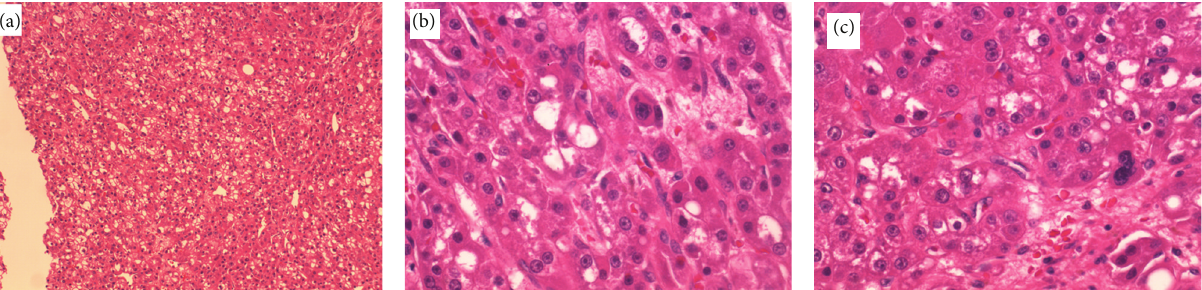
Figure 3: Moderately differentiated HCC, hematoxylin and eosin: low power (a) and high power (b and